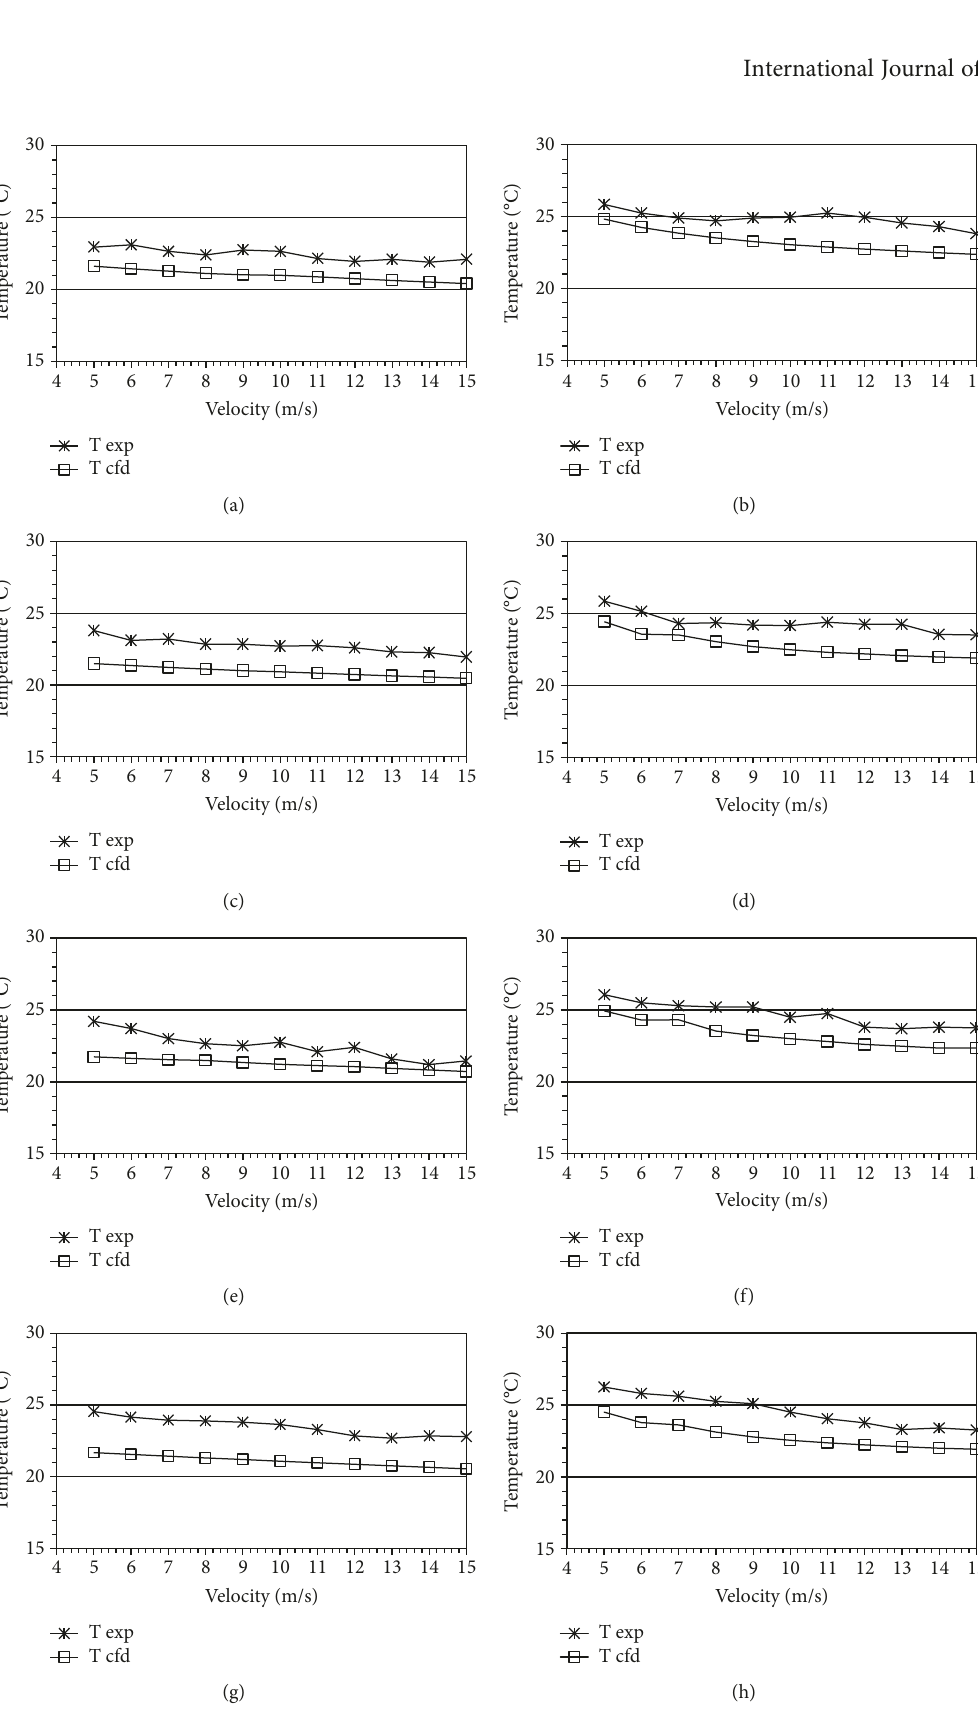
Figure 6: Comparison between experimental and CFD temperature results. (a) Monocrystalline at 0 ° initial point, (b) monocrystalline at 0 ° fi nal point, (c) monocrystalline at 10 ° initial point, (d) monocrystalline at 10 ° fi nal point, (e) polycrystalline at 0 ° initial point, (f) polycrystalline at 0 ° fi nal point, (g) polycrystalline at 10 ° initial point, and (h) polycrystalline at 10 ° fi nal